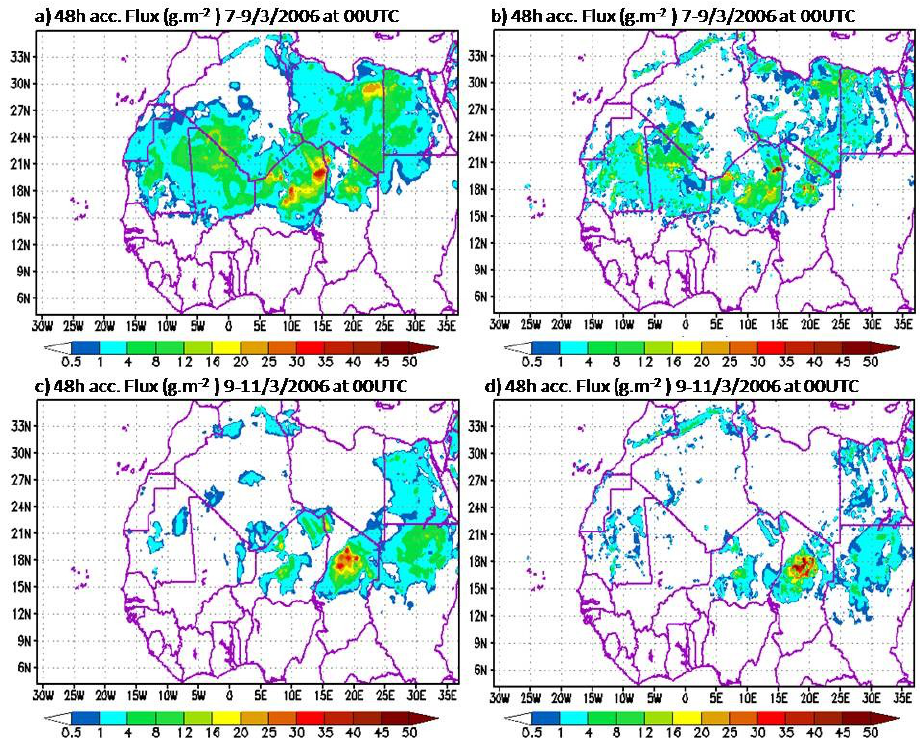
Fig. 16. 48-h accumulated dust fluxes (in gm − 2 ) simulated by ALADIN with EXP3 (a) and (c) and EXP4 (b) and (d) for 7–9 March , 9–11 2006 and at 00:00 Fig. 16 . 48-hour accumulated dust fluxes (in gm -2 ) simulated by ALADIN with EXP3 (a and 3 c) and EXP4 (b and d) for March 7-9, and 9-11, 2006 at 00UTC. 4